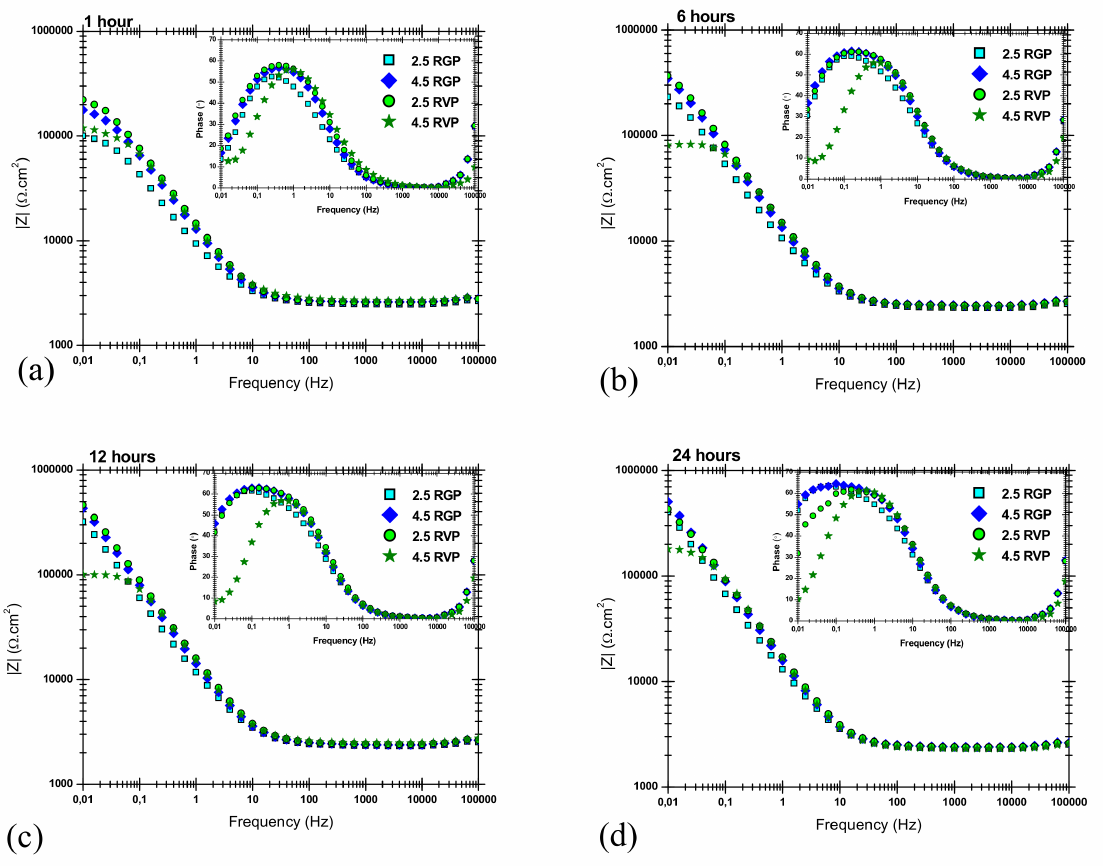
Figure 13. Bode plots of EIS spectra of samples 2.5 RGP, 4.5 RGP, 2.5 RVP, and 4.5 RVP after ( a ) 1 h; ( b ) 6 h; ( c ) 12 h and ( d ) 24 h of immersion in the diluted Harrison